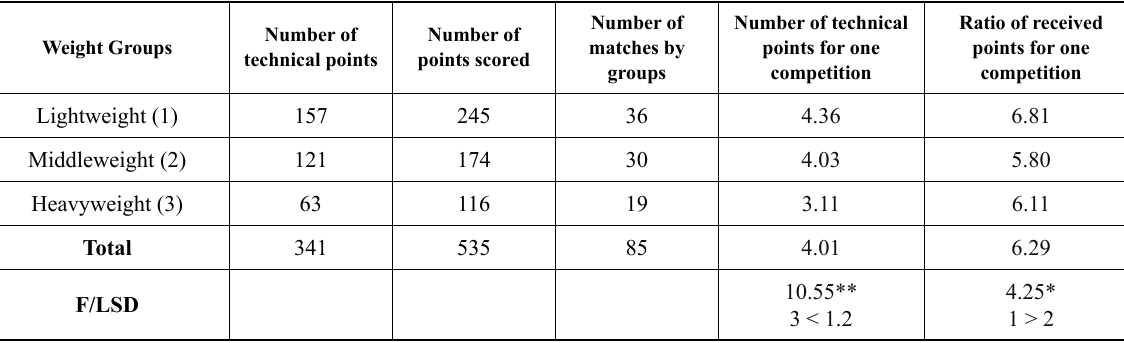
Table 2. Distribution of technical and match numbers scored by each weight group